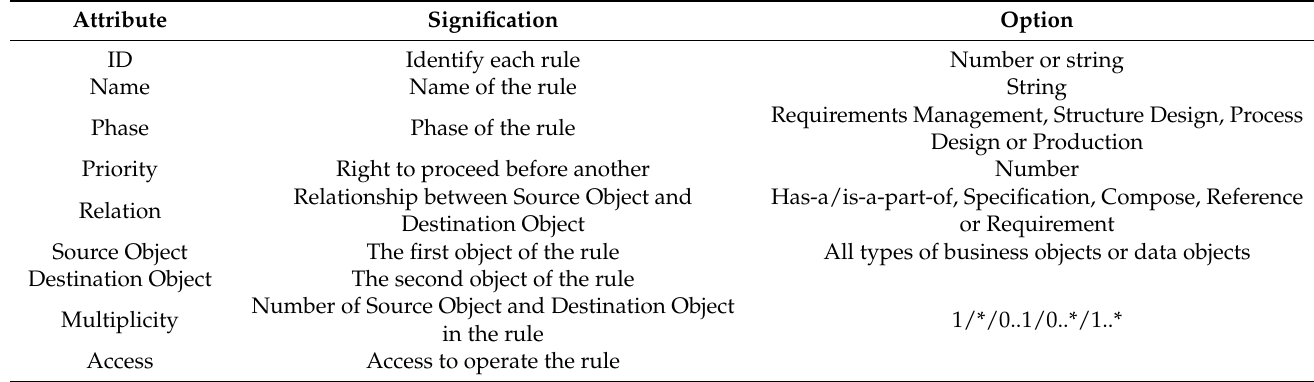
Table 4. Attributes of rules (1, * represent the one and